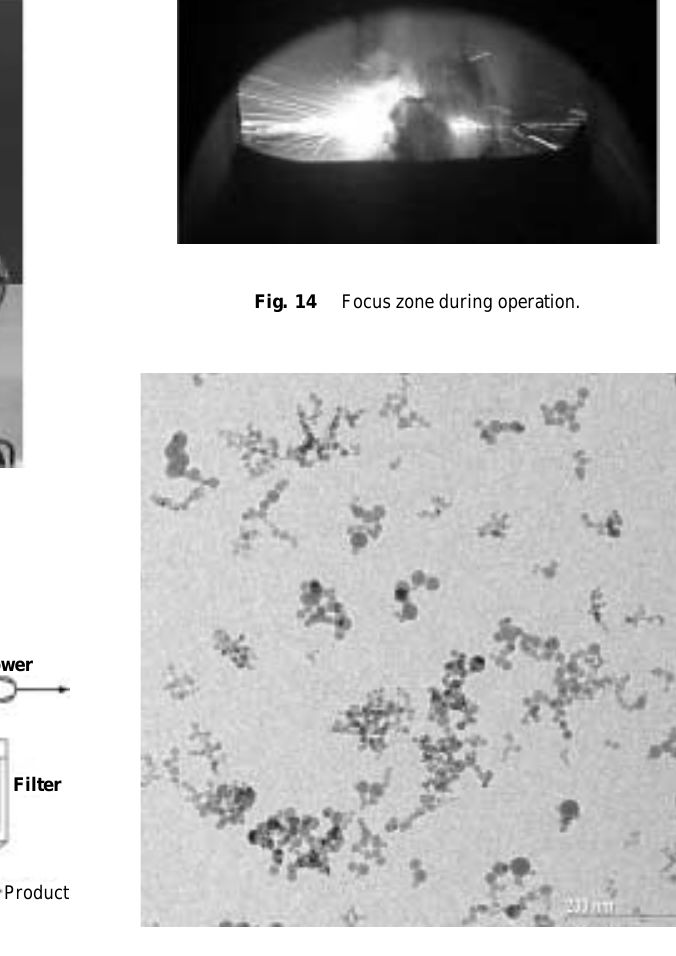
Fig. 13 Schematic process flow diagram of the laser reactor.